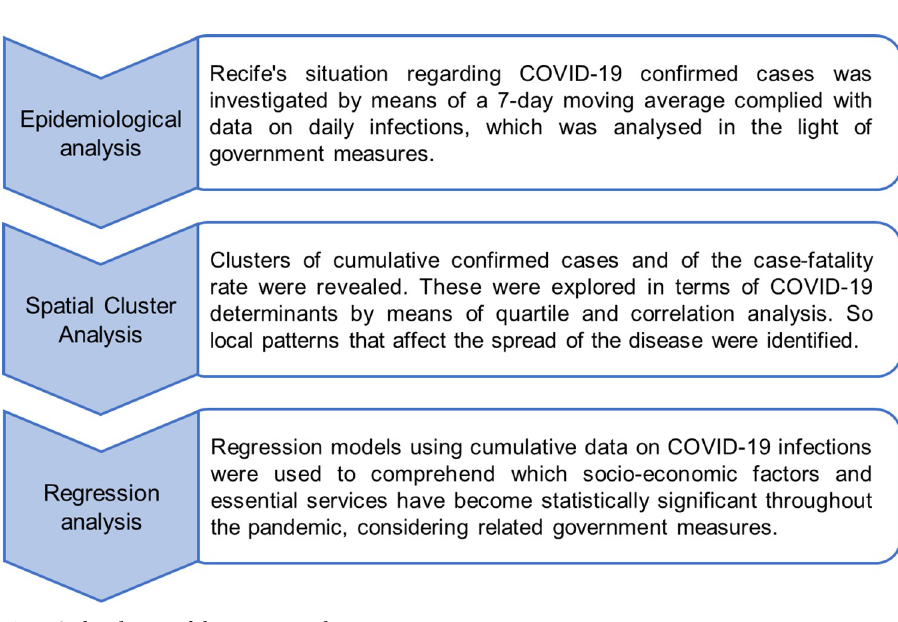
Fig 1. Ordered steps of the present study.